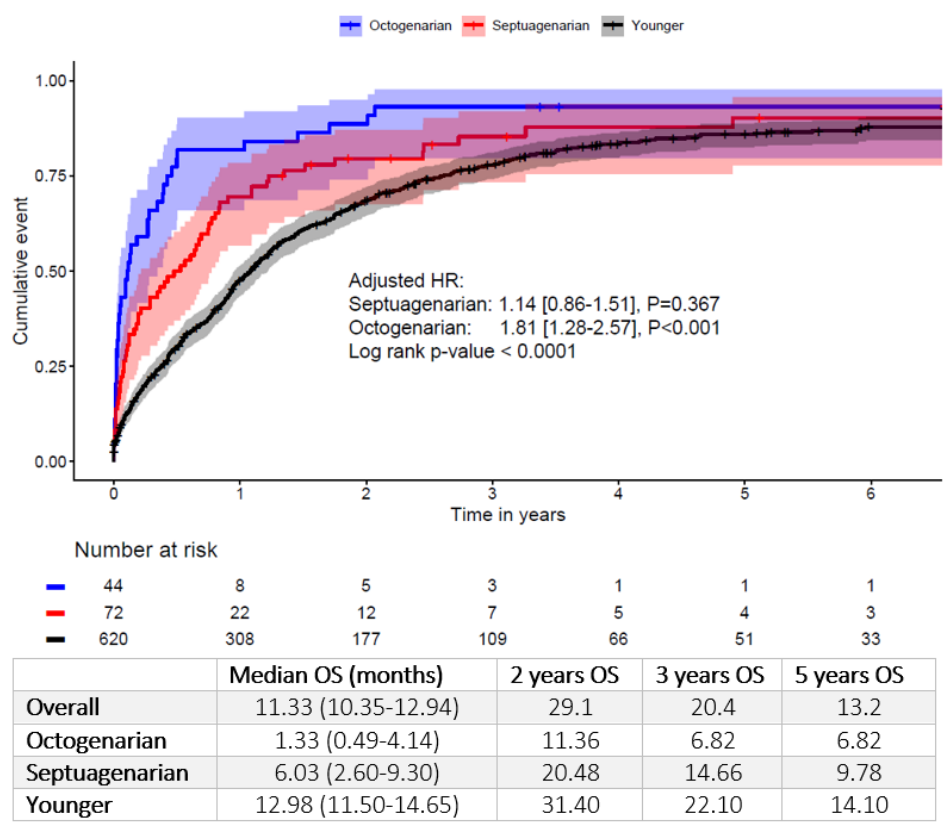
Figure 1. Cumulative death from any cause among different age categories (the younger category was used as reference for the obtained hazard ratios).